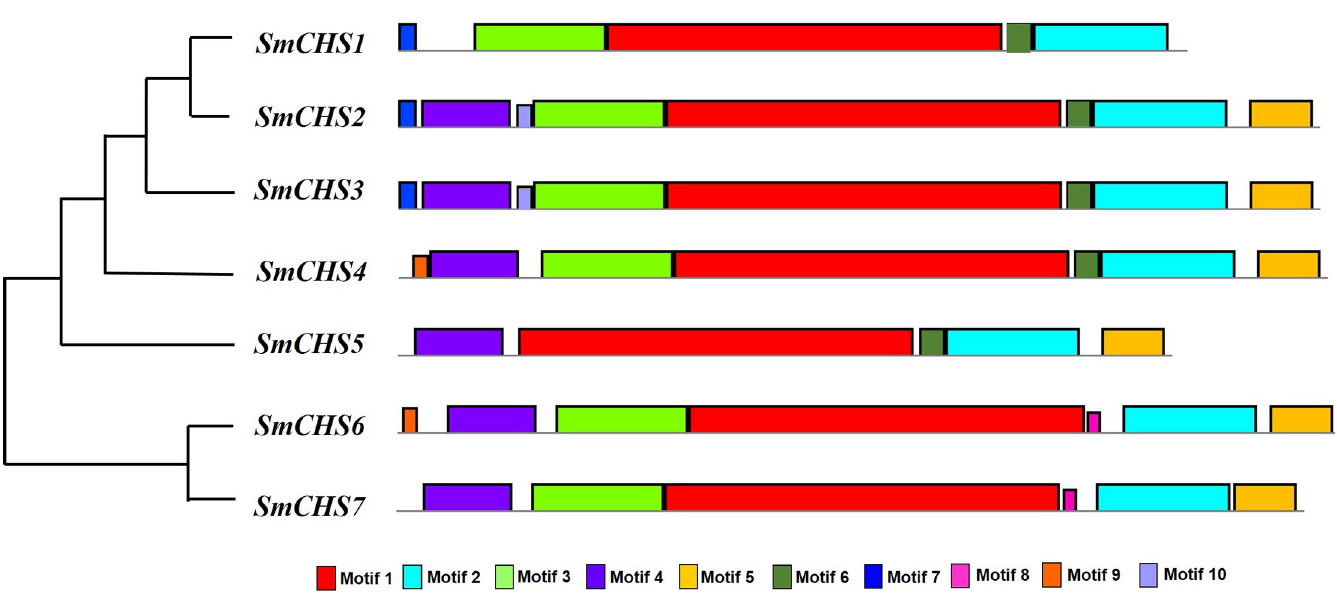
Fig 2. Motifs conserved across all CHS proteins in eggplant. Ten conserved motifs are indicated in differently colored boxes. eleven. The 7 SmCHS were categorized into 6 groups (groups Ⅰ , Ⅱ , Ⅶ , Ⅷ , Ⅸ and Ⅹ ), and group Ⅱ contained SmCHS1 and SmCHS2 . Groups Ⅰ , Ⅱ , Ⅸ and Ⅹ exist in all eight species, and groups Ⅲ , Ⅳ and Ⅴ were absent in Solanum melongena L., Solanum penellii , Solanum lycoper-